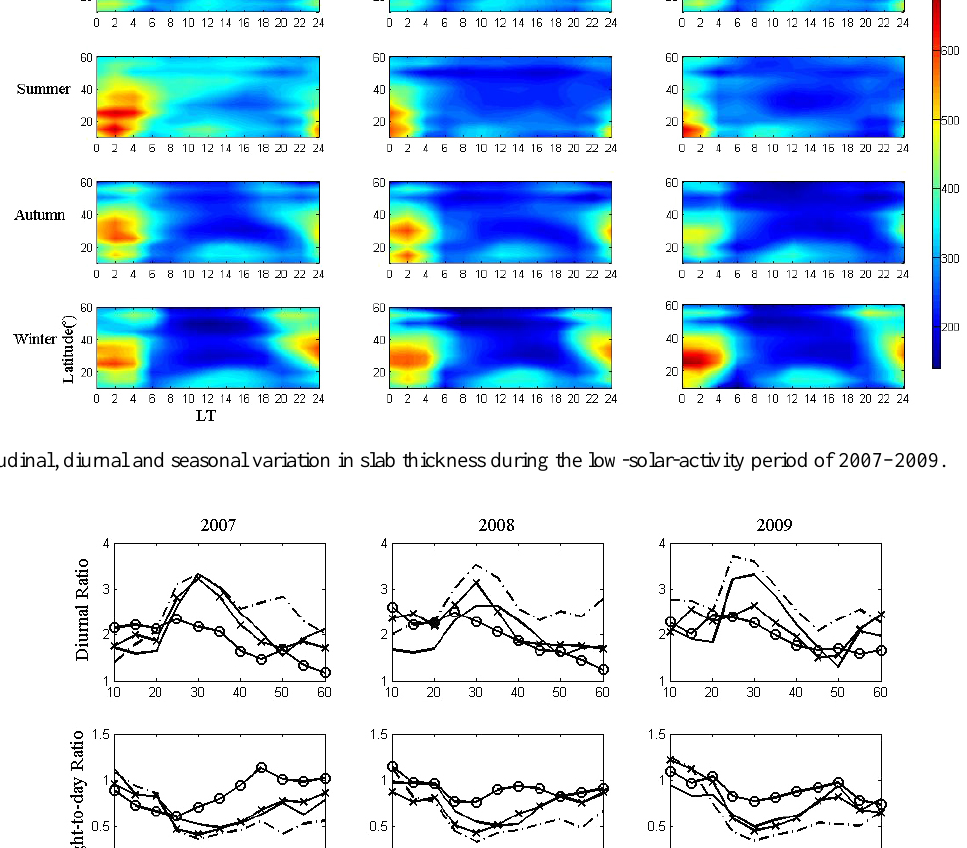
protonosphere plasma flux changes direction (Jayachandran et al.,